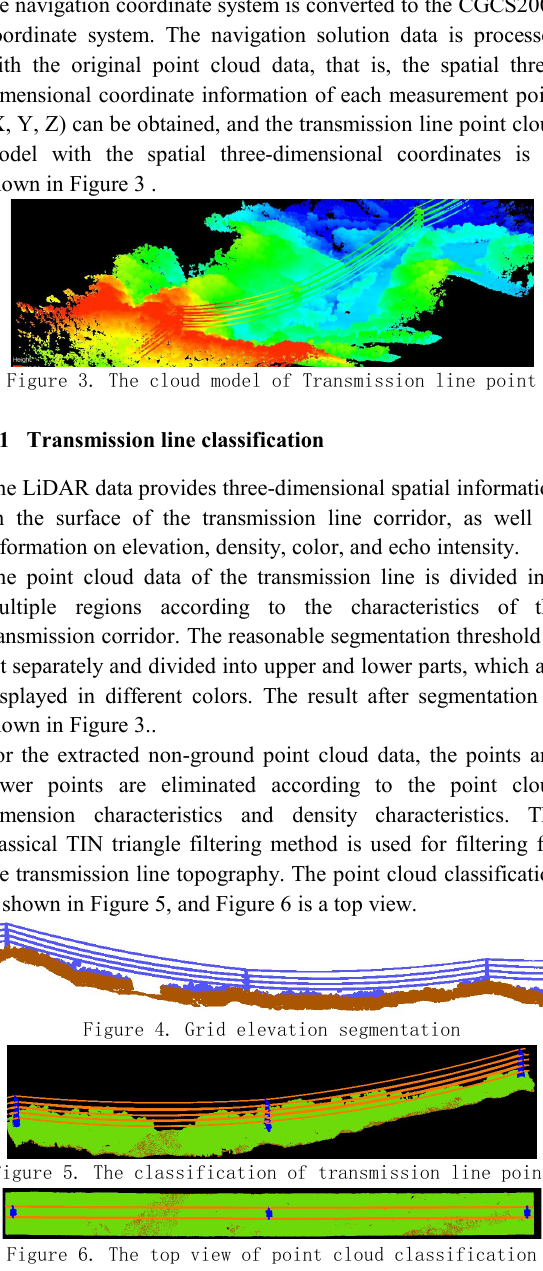
Figure 5. The classification of transmission line point